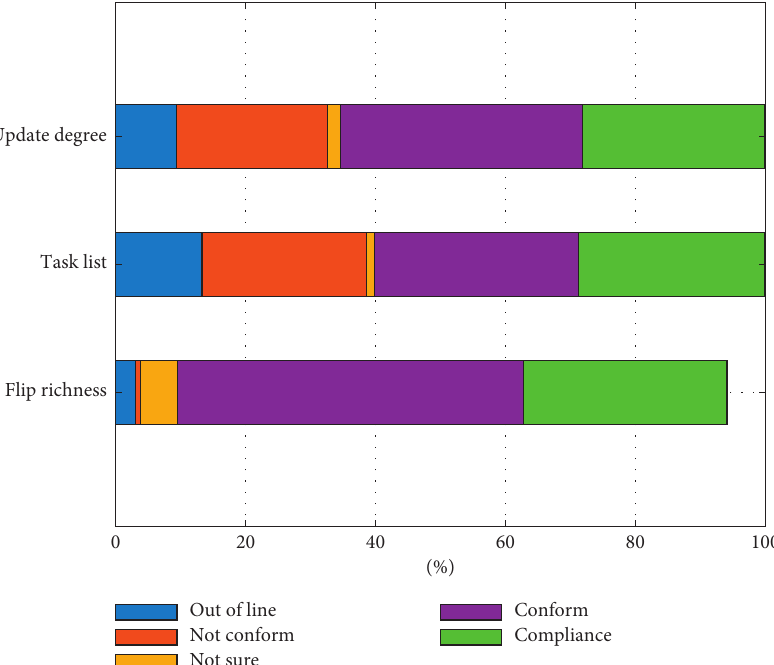
Figure 7: Percentage of resource